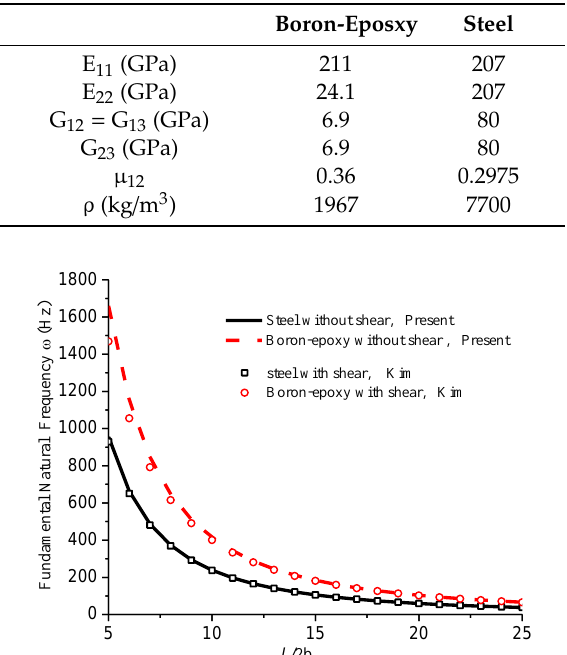
Table 2. Comparison of the fundamental natural frequency based on different theory (Ω = 0). L/2b